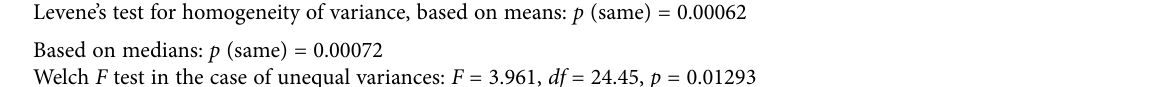
Table 2. Magnitude of annual average precipitation ( P ) in mm, annual averages of indicators of erosivity: R